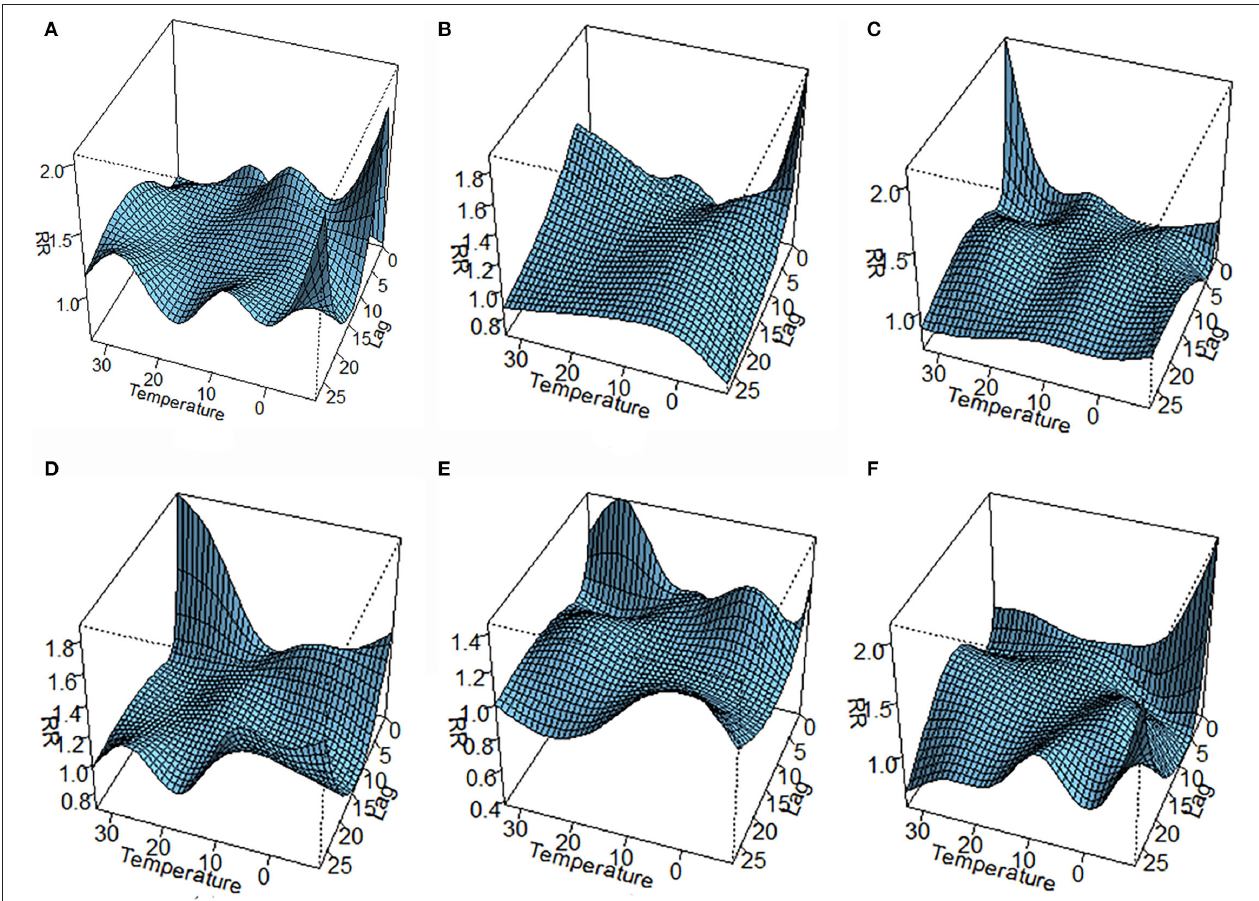
FIGURE 6 | The three-dimensional lag–response to temperature based on stratification of age [ (A) age ≤ 30 group; (B) 30 < age ≤ 40 group; (C) 40 < age ≤ 50; (D) 50 < age ≤ 60; (E) 60 < age ≤ 70; (F) age >